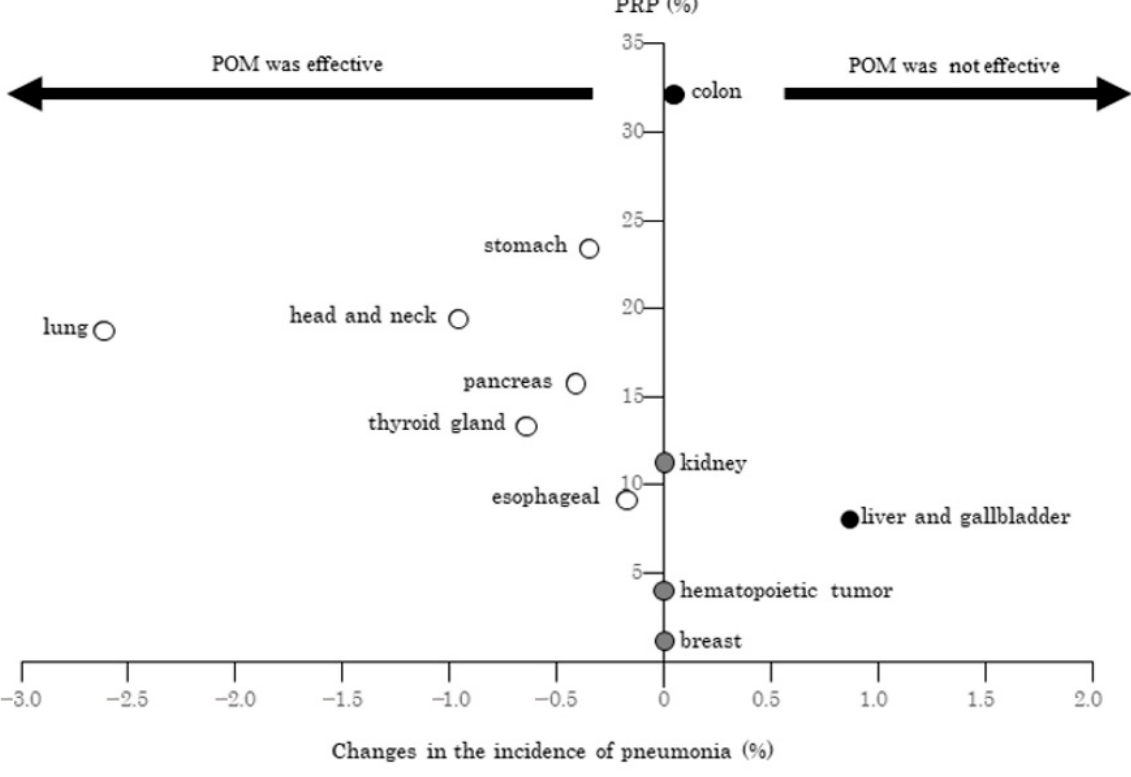
Figure 3. Relationship between changes in the incidence of pneumonia and performing rate of POM.